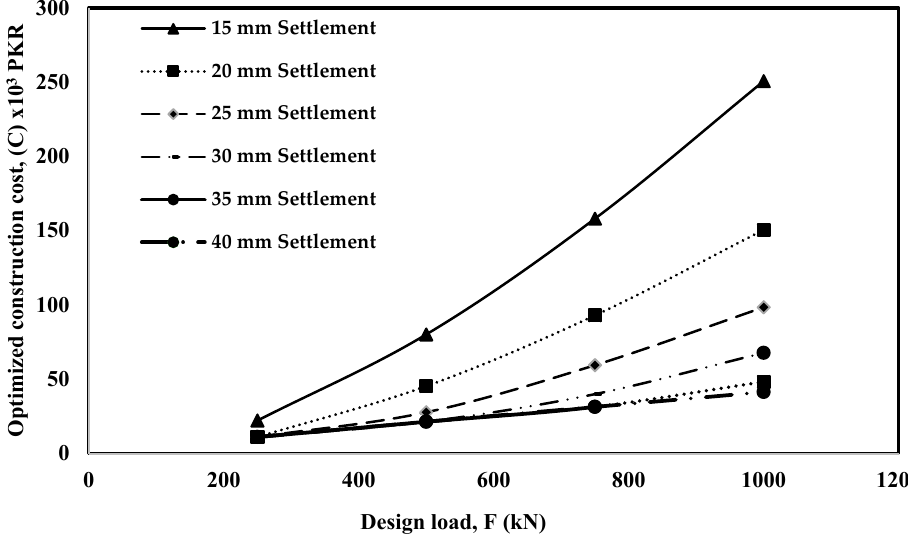
Figure 8. Variation of optimized cost under different SLS requirements.